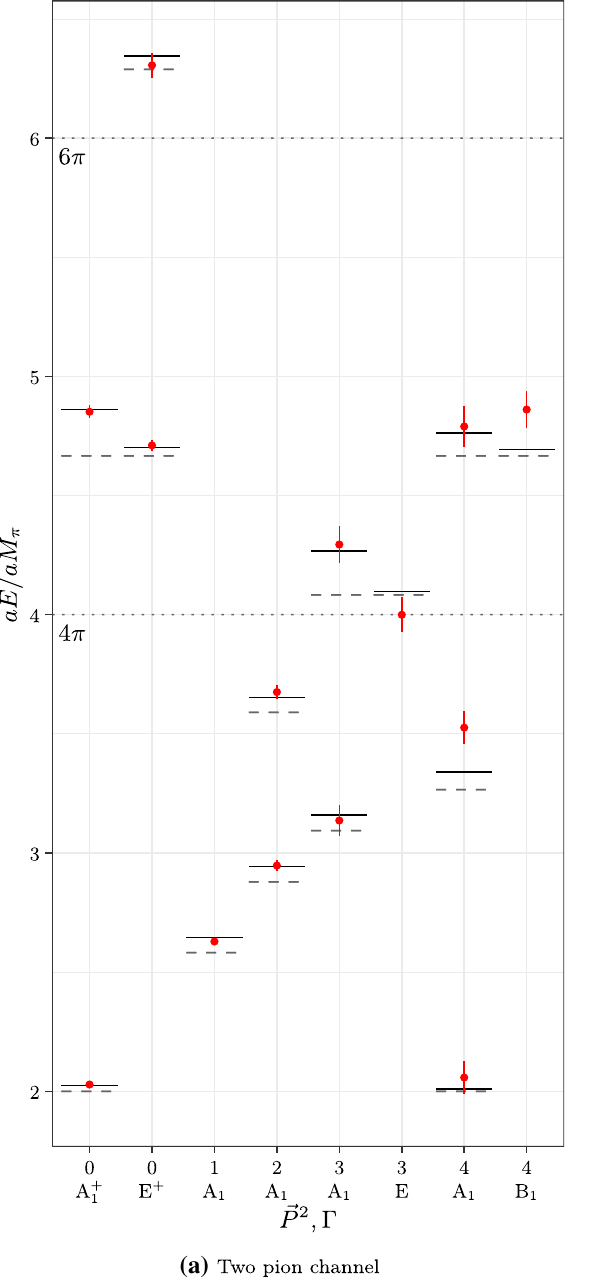
non- A 1 two-pion levels, which are dominated by d -wave interactions, we use the fit in Table 4 in the main text. The short dashed gray lines denote the noninteracting energy levels. We also include the relevant inelastic thresholds as long dotted gray